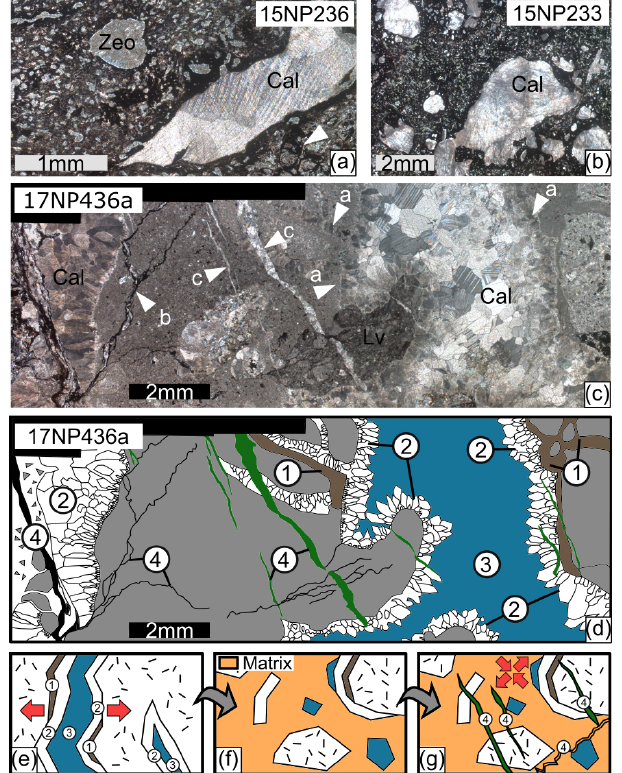
Figure 3. Typical calcite-filled vesicles from sample 15NP236 (a) , in this case with spary calcite and zeolite mineralization. The white arrow marks preserved perlitic structures. Botryoidal calcite was found in both amygdaloid-basalt samples; the example in (b) is from 15NP233. Panel (c) shows a thin section photograph of sam- ple 17NP436a. White arrows indicate radial fibrous calcite (a) , dark stylolites (b) , and calcite-filled fissures (c) . (a–c) Under crossed po- larized light. Panel (d) shows a schematic sketch of microphoto- graph (c) , delineating a sequence of four events: (1) formation of hy- drothermal clay, (2) precipitation of fibrous-radial calcite along the walls of brecciated volcanic rock fragments, (3) late-stage equant calcite formation, and (4) pressure solution and formation of sty- lolites (dark lines) and reprecipitation of dissolved calcite in fis- sures (green). Areas 2 and 3 are targets for laser ablation. In (e) and (f) a schematic sequence of events leading to the formation of the basaltic breccias is sketched. (e) Fracturing of the basaltic rock and formation of clay (1) and calcite cement phases (2) and (3). (f) Dis- articulation and sedimentation of debris containing isolated cal- cite cement fragments. (g) Late-stage pressure solution and fissure formation of phase (4). Red arrows schematically indicate stress regime.